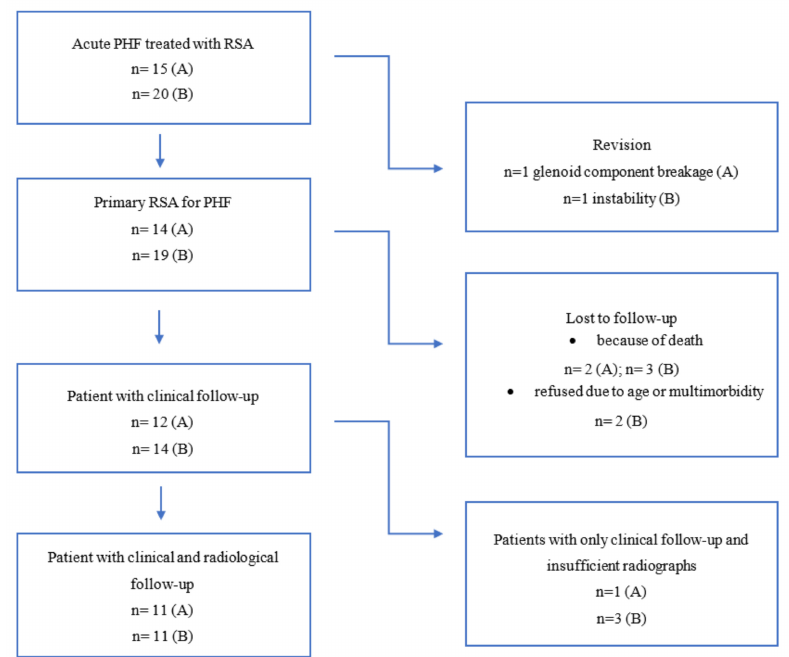
Figure 4. Study flow-chart with regards to patients treated with the fracture-specific stem (A) and the conventional stem design (B). (RSA—reverse shoulder arthroplasty, PHF—proximal humerus